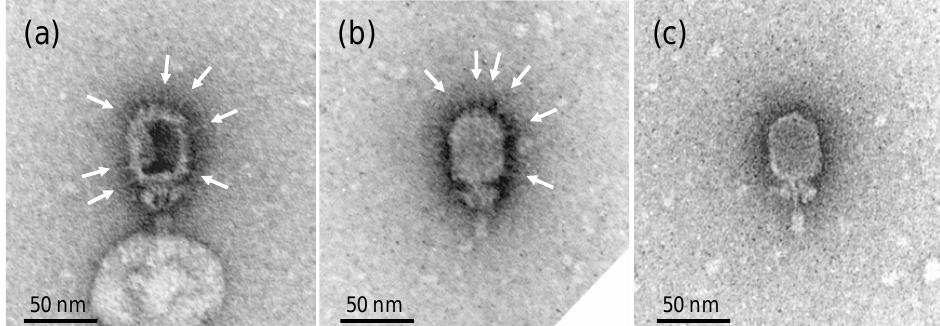
Figure 2. Morphology of Goe1 and Goe1 Δc00180. Transmission electron micrographs of negatively